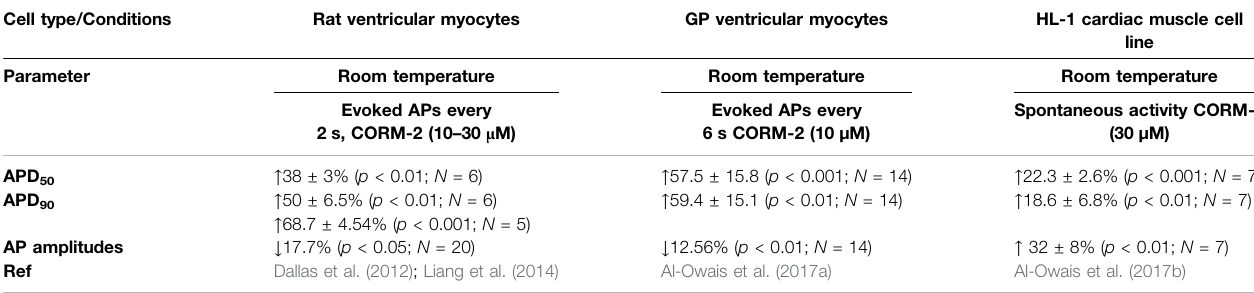
TABLE 1 | summary in vitro changes in action potential characteristics produced by